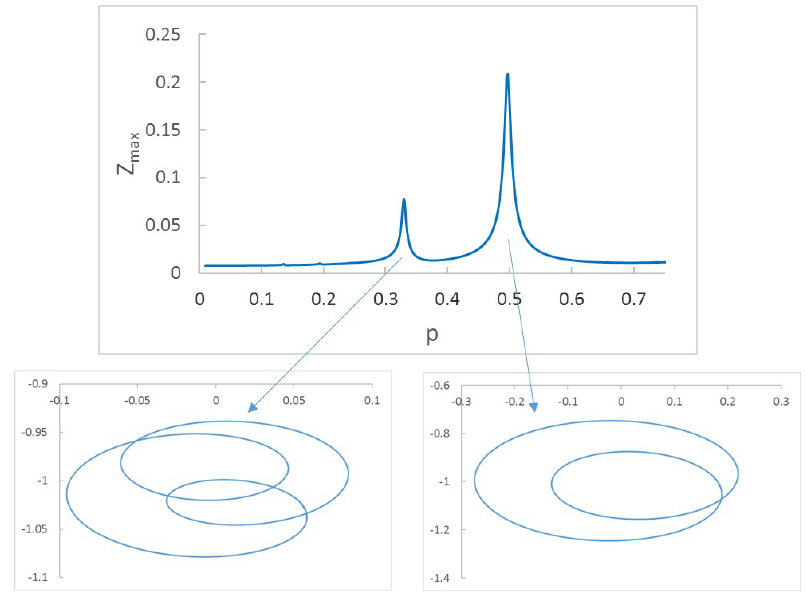
Figure 4. Peaks in sweep and orbits for α = 0.2.